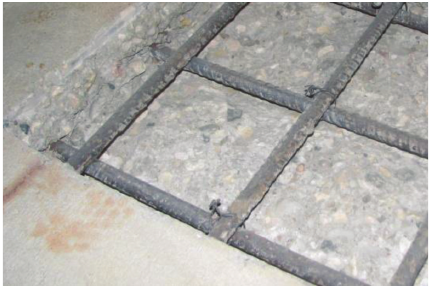
Figure 12: Steel rating of 2 and 3 (close-up of exposed Rebar of control after 3 months).